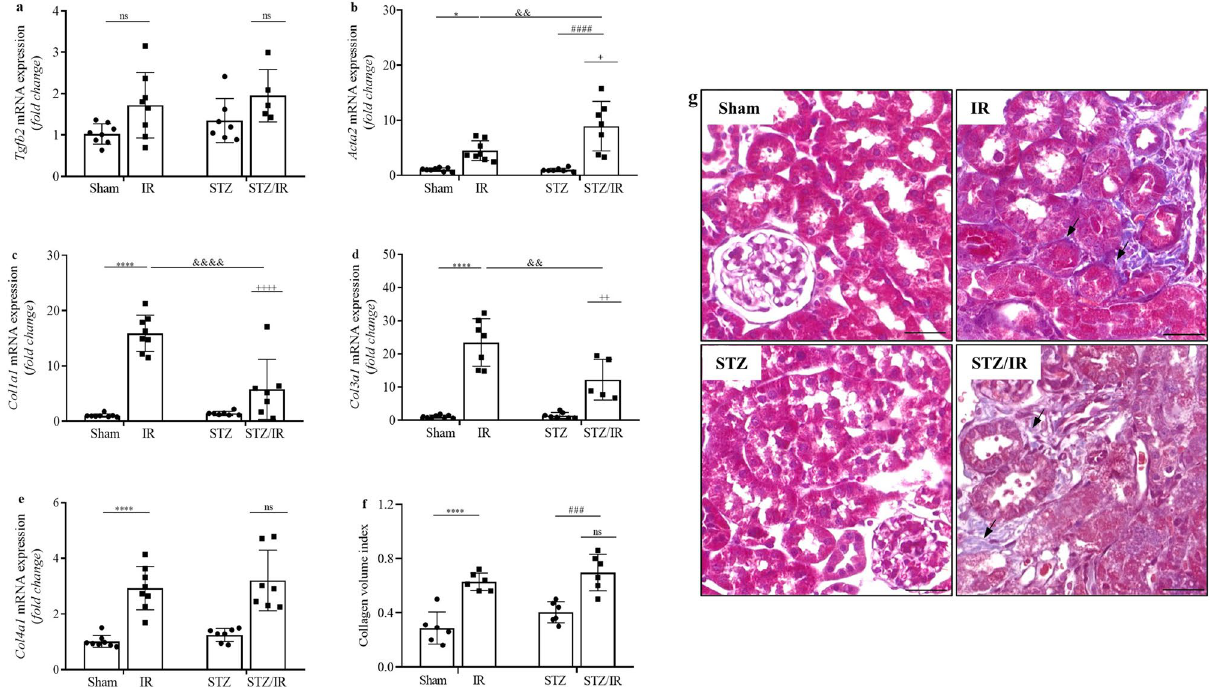
Figure 6. Effect of renal ischemia/reperfusion in vehicle- and STZ-treated mice on Tgfb2 (TGF-β2) ( a ), Acta2 (α-SMA) ( b ), Col1a1 (collagen I) ( c ), Col3a1 (collagen III) ( d ), and Col4a1 (collagen IV) ( e ) mRNA expression; interstitial collagen volume ( f , g ). + p < 0.05, ++ p < 0.01, ++++ p < 0.0001 for the interaction between diabetes and renal IR (STZ/IR), as indicated by two-way ANOVA (Supplementary Table S2). The Bonferroni post hoc test was also performed: *p < 0.05, ****p < 0.0001 vs sham group; ### p < 0.001, #### p < 0001 vs STZ group; && p < 0.01, &&&& p < 0.0001 vs IR group. The black arrows indicate interstitial collagen volume. The values are the mean ± SD (n = 5–8). For morphological studies, fixed 4-µm-thick kidney slices were stained with Masson’s trichrome, and the images were captured and analyzed using NIS-Elements (Nikon) software coupled to a light microscope equipped with a ×40 objective (Eclipse 80i, Nikon, Tokyo, Japan). Bars = 50 µm. Sham sham-operated, IR ischemia/reperfusion, STZ streptozotocin, STZ/IR streptozotocin/ischemia/reperfusion, ns